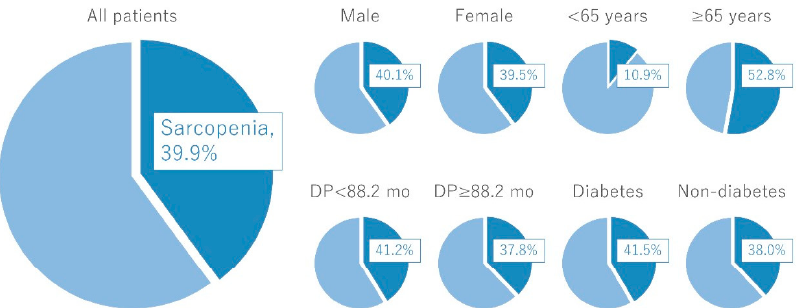
Figure 2. Prevalence rate of sarcopenia in patients undergoing hemodialysis, created based on a reference from Kakita et al. [34]. DP: dialysis